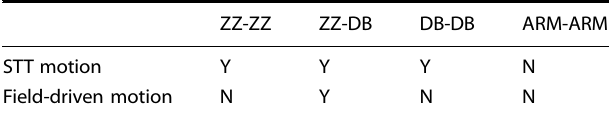
Table 1. Summary of the possible combinations of edges (zigzag (ZZ), armchair (ARM) and dangling bond (DB)) terminating a monolayer MnPS 3 that may induce (Y) or not (N) the domain wall motion under current (spin-transfer torque (STT)) or magnetic fi